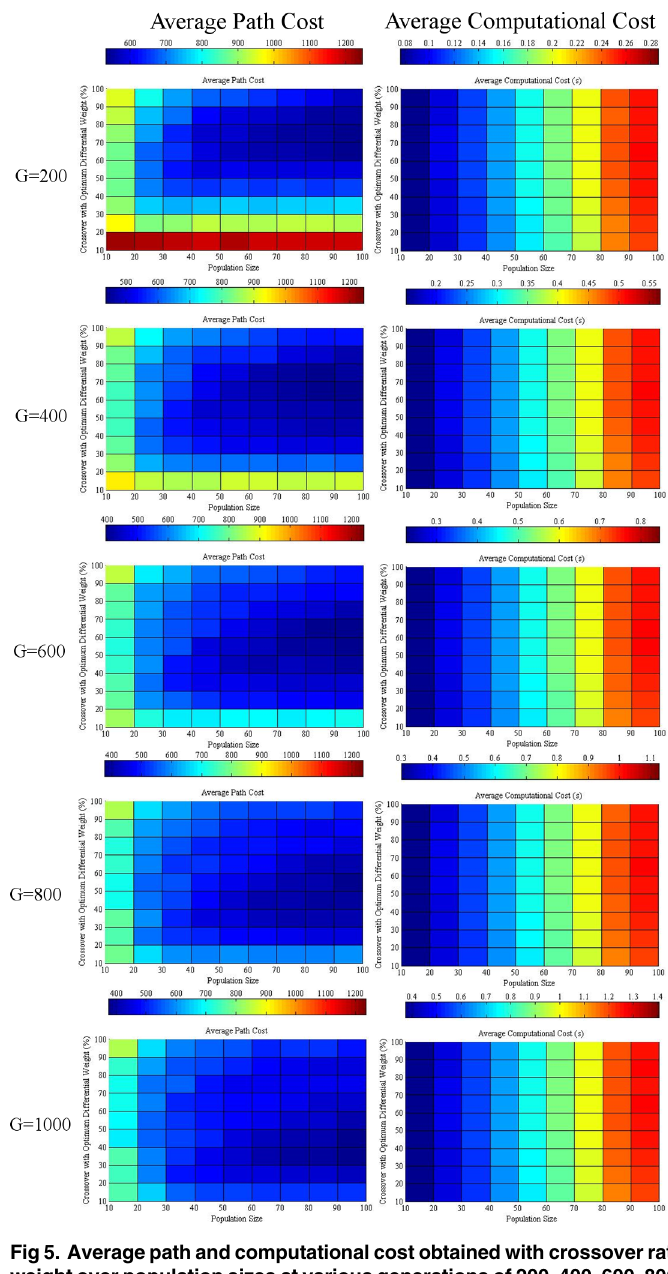
Fig 5. Average path and computational cost obtained with crossover rates on the optimum differential weight over population sizes at various generations of 200, 400, 600, 800, and 1000 “ Table B in S1 Dataset.